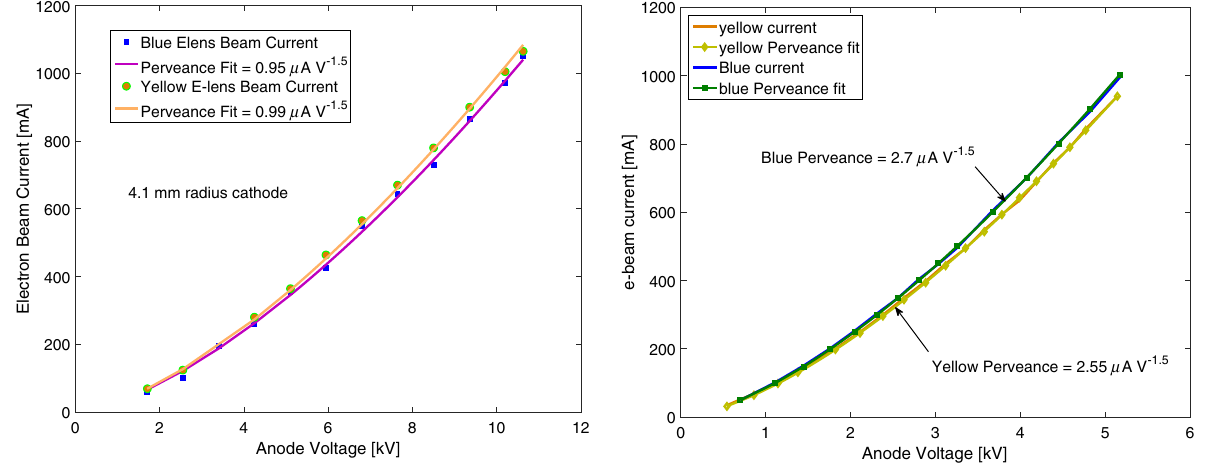
FIG. 6. Electron gun perveance for the 4.1 mm radius cathode (left) and 7.5 mm radius cathode